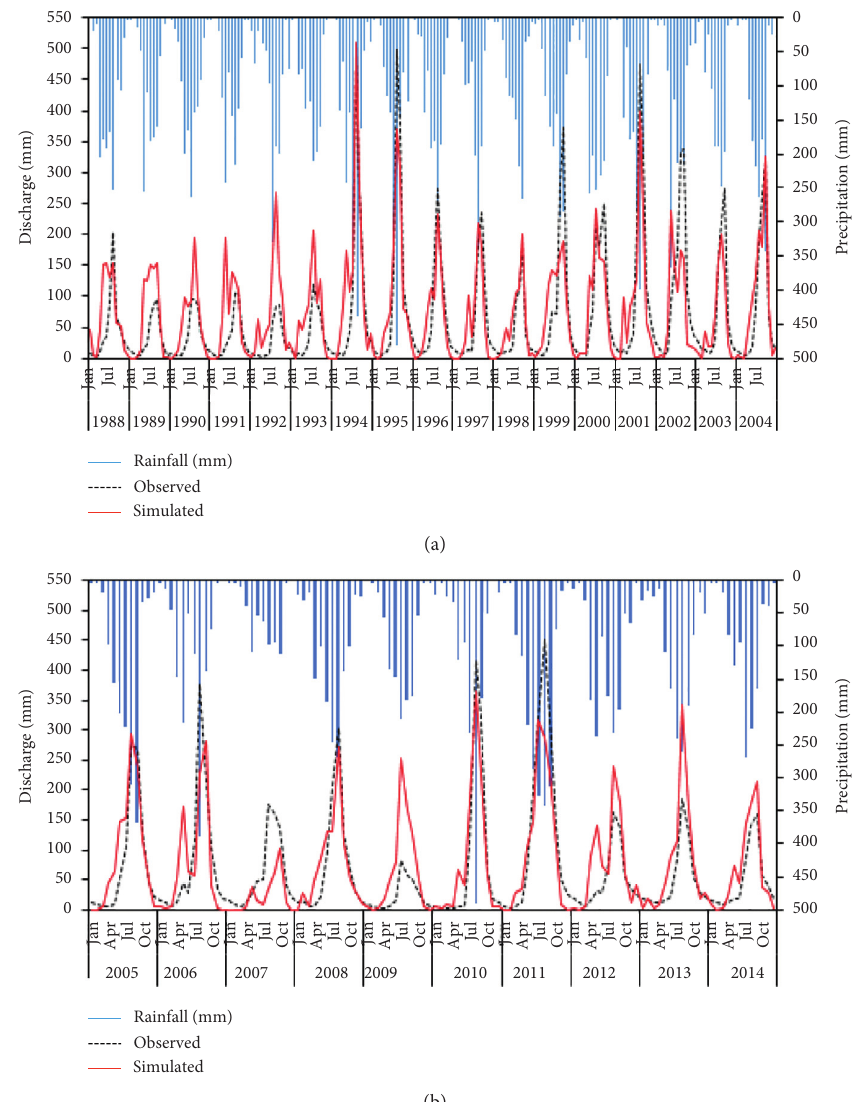
Figure 3: (a) Hydrographs during calibration (1988–2004) and (b) validation